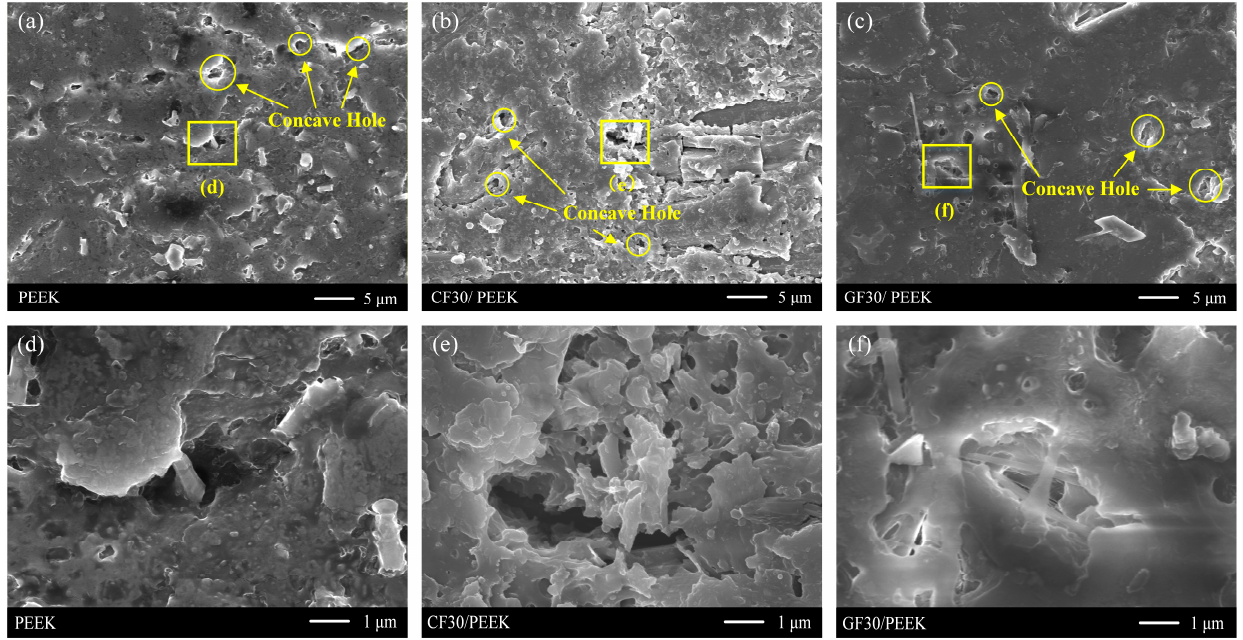
Figure 3. Morphology after roughening of different sample: ( a ) PEEK; ( b ) CF30/PEEK; ( c ) GF30/PEEK; ( d ) hole on the PEEK; ( e ) hole on CF30/PEEK; ( f ) hole on GF30/PEEK.